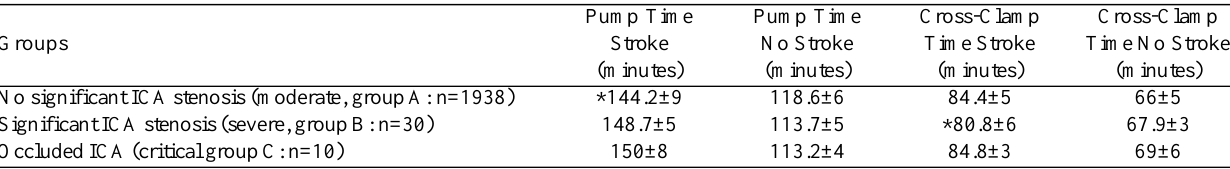
Table 3. Mean Pump, Cross-Clamp Time, Patients with/without Stroke in Different Groups.